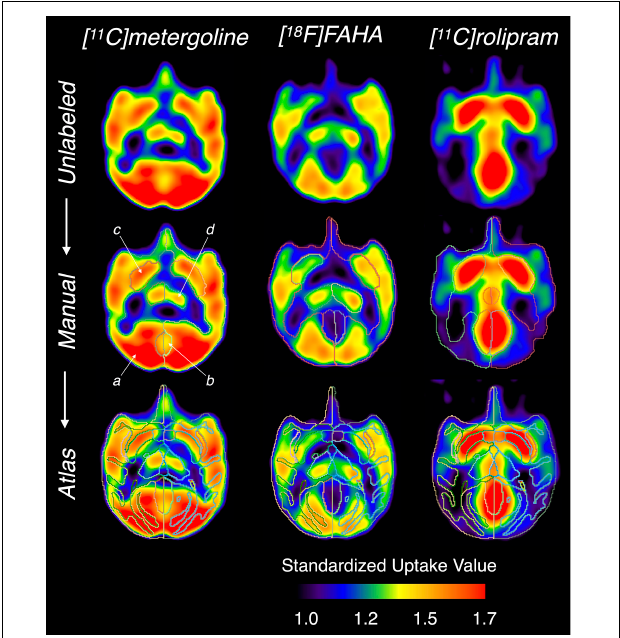
FIGURE 6 | Comparison of the manual and atlas-based segmentation performed on different PET images. From the top row : unlabeled PET images, with manual segmentation, and with atlas-based segmentation. (a) cerebral cortex, (b) cerebellum, (c) putamen, (d)